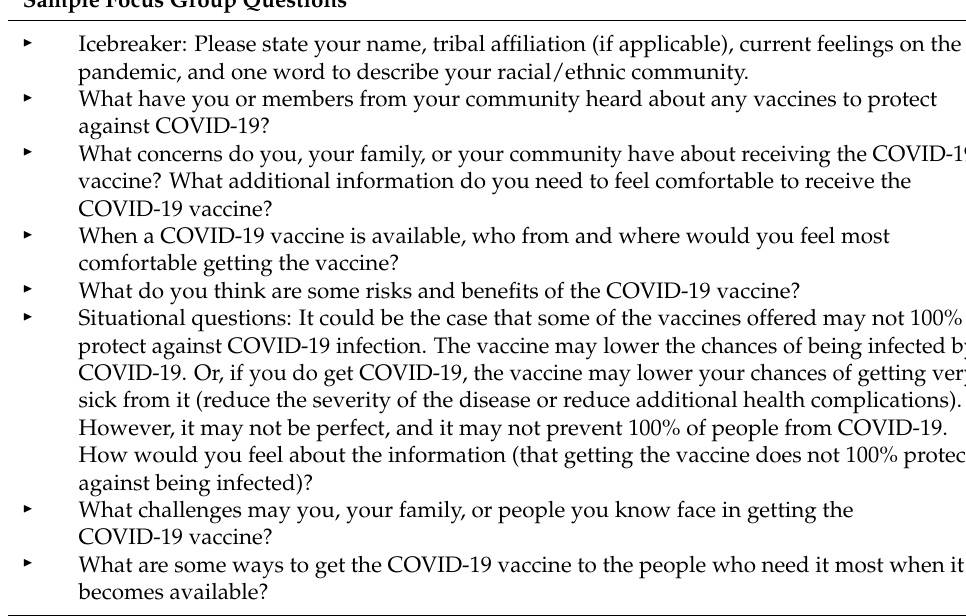
Table 1. Focus Group Question Guide. Sample Focus Group